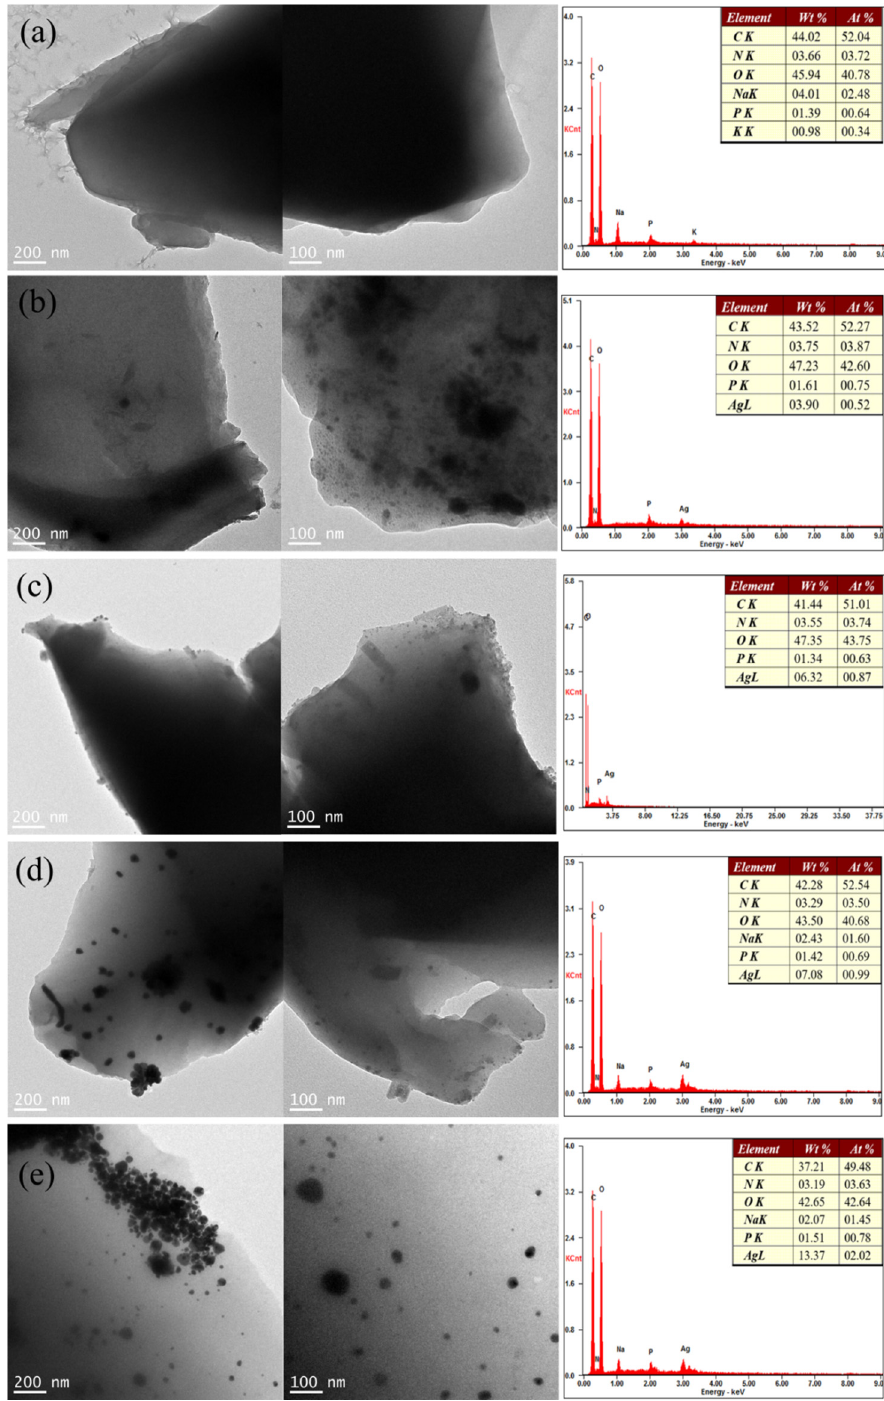
Figure 4. Element analysis and TEM images of CD-CA/PDA ( a ), CD-CA/PDA-0.5Ag ( b ), CD- CA/PDA-1Ag ( c ), CD-CA/PDA-2Ag ( d ) and CD-CA/PDA-4Ag ( e